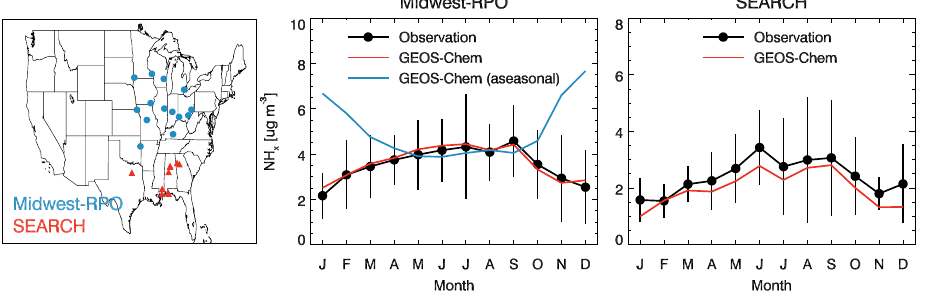
Fig. 2. Atmospheric concentrations of total reduced nitrogen (NH x ≡ NH 3 + NH + ) at the Midwest-RPO and SEARCH networks. Site 4 locations are shown in the left panel. Monthly mean concentrations averaged across all sites of each network are shown in the central and right panels. Observations (black) are compared to model results using the NEI NH 3 anthropogenic emissions with no seasonal variation (blue line in the central panel) and with seasonal variation fitted to the Midwest-RPO data (red lines). The Midwest-RPO and SEARCH data are for 2004-2005 and 2006, respectively, and model results are for 2006. Vertical bars represent standard deviations in the observed monthly means for individual sites and